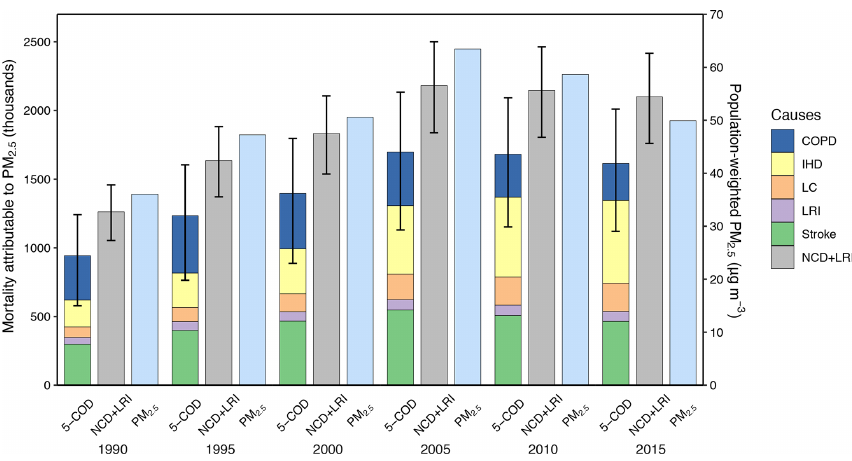
Figure 2. Historical trends of national population-weighted PM 2 . 5 concentrations (µgm − 3 ) and PM 2 . 5 -related premature mortality shared by disease causes (thousands) estimated with GEMM NCD + LRI and GEMM 5-COD functions.